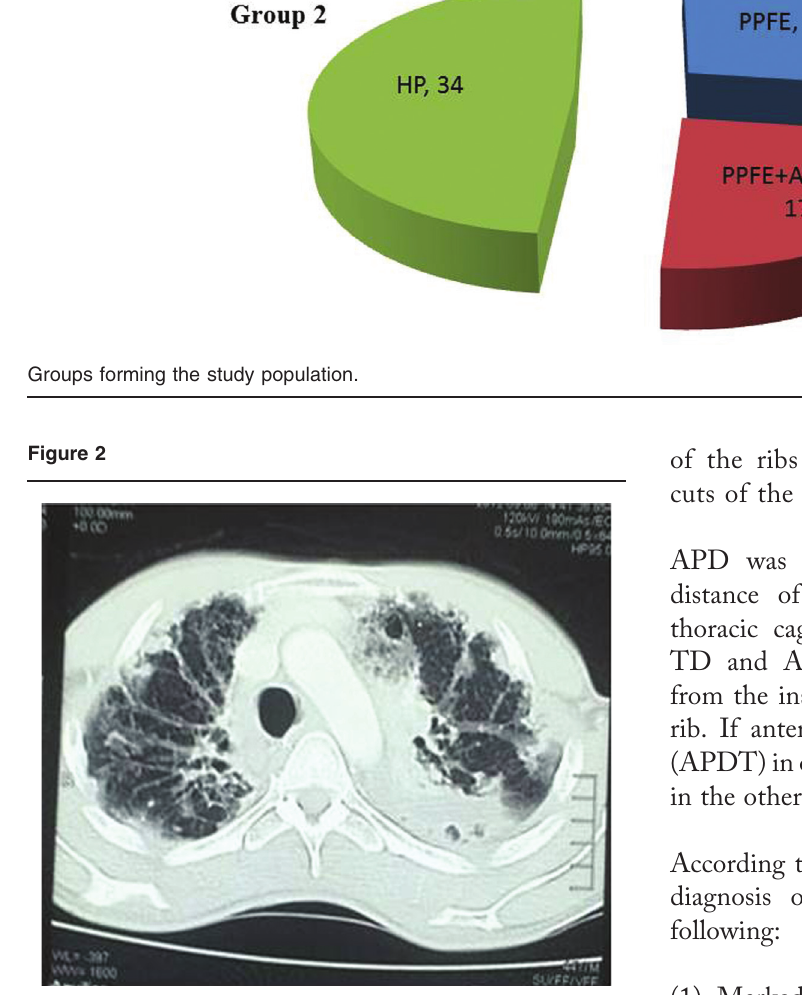
CT chest axial cuts showing classic picture of PPFE: upper lobe predominance, cervical pleura thickening, reticulations, and traction bronchiectasis. CT, computed tomography; PPFE, pleuropulmonary